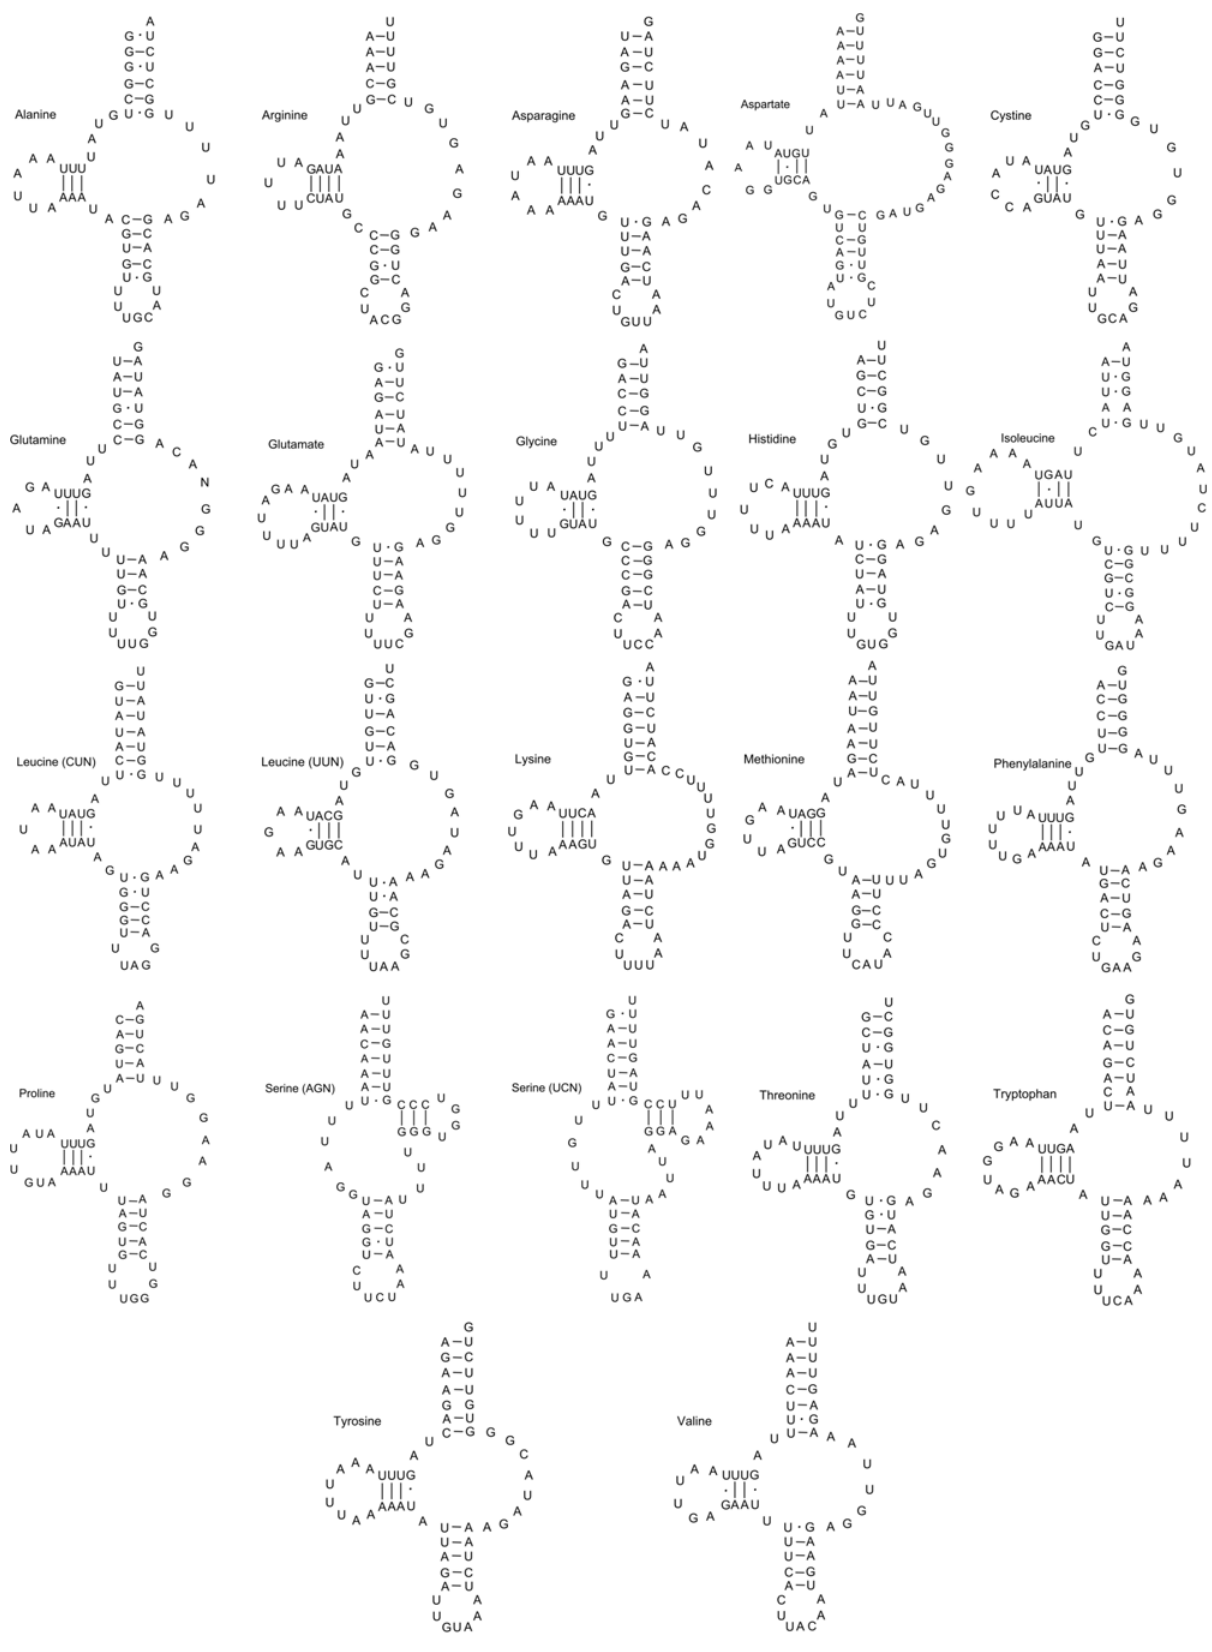
Figure 2. Secondary structures predicted for the 22 tRNA genes in the mitochondrial genome of Toxocaracanis (cf. [ 15,18 ] ).